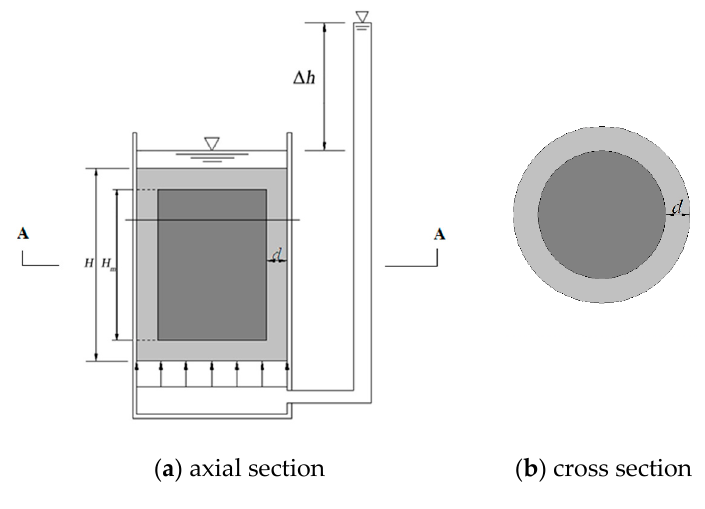
Figure 1. Soil-cement specimen.